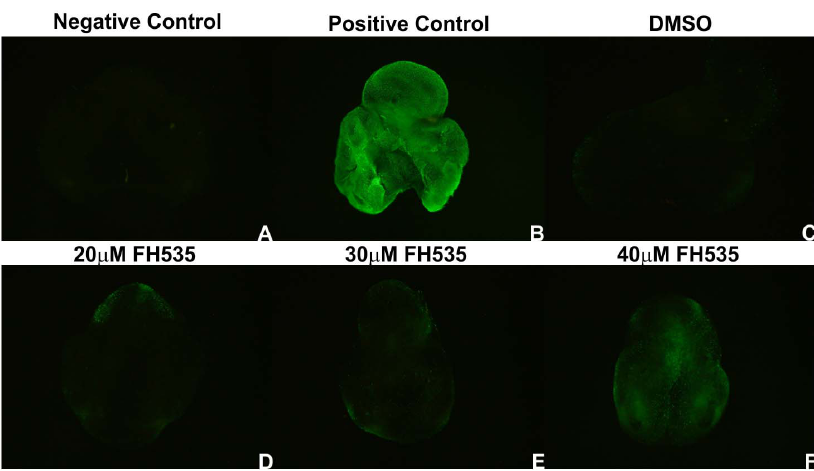
Figure 8. TUNEL assay in chick lung explants. Representative examples of negative (A) and positive control (B), DMSO (C), 20 m M (D), 30 m M (E) and 40 m M (F) FH535 treated stage b2 explants; n 5 4 per condition. Negative control explants were incubated without TUNEL mix solution. Positive control explants were incubated with DNase at 37 ˚ C for 90 minutes.